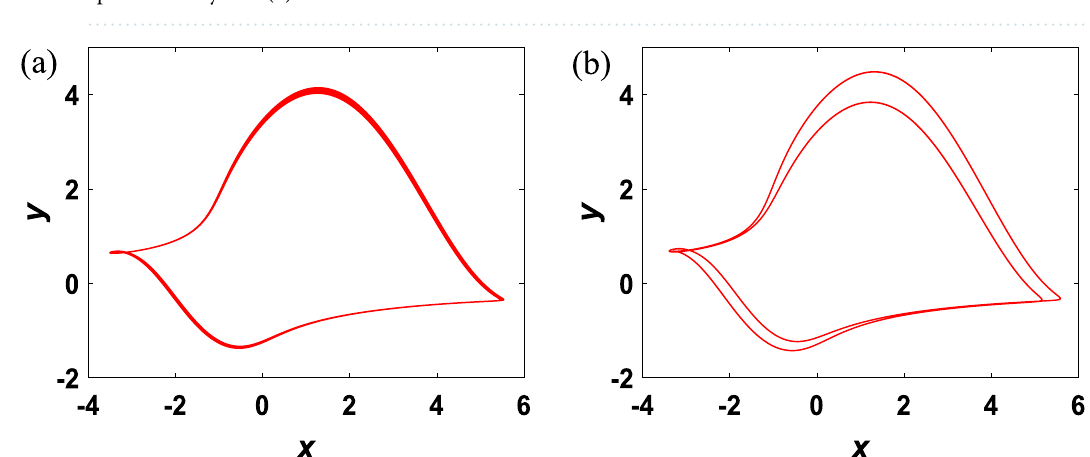
Figure 4. For the initial values (− 0.1, − 2, 0.1), the phase diagrams of system (3) in x – y plane: ( a ) quasi- 0.147 . ( b ) Period state with ν 1 periodic state with ν 1 =